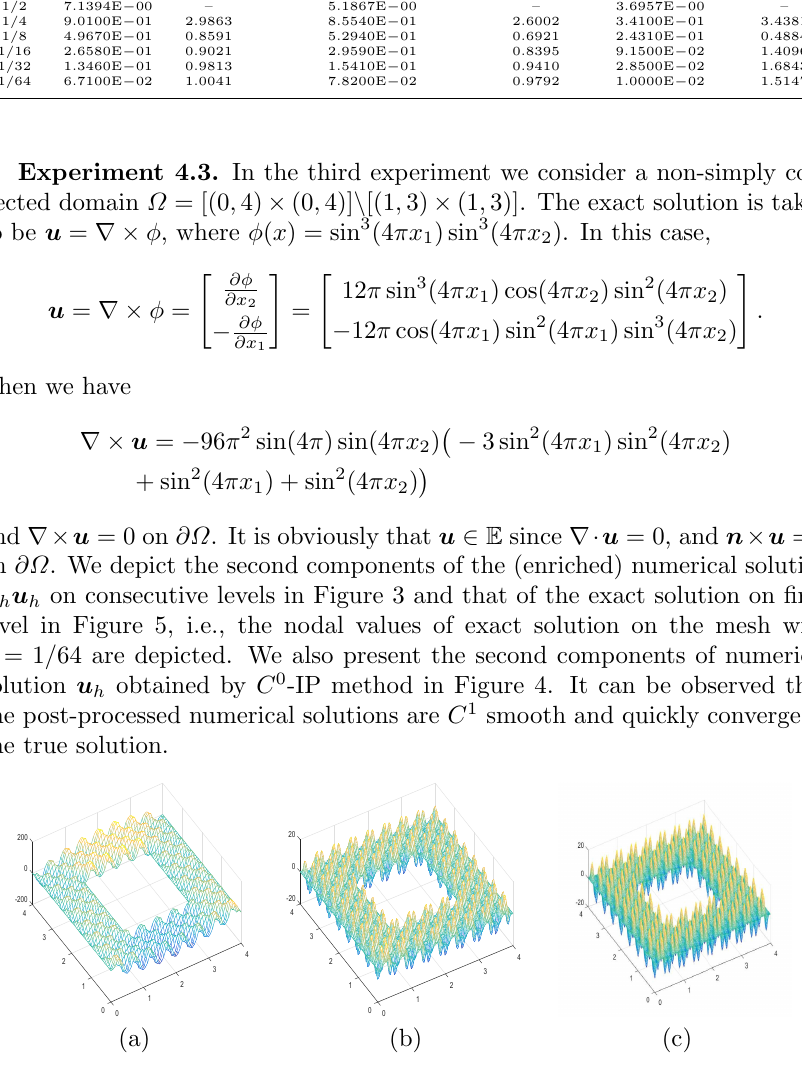
Figure 3. Post-processed (enriched) solution u 2 for (a) h = 1 / 16; (b) h = 1 / 32; (c) h = 1 /